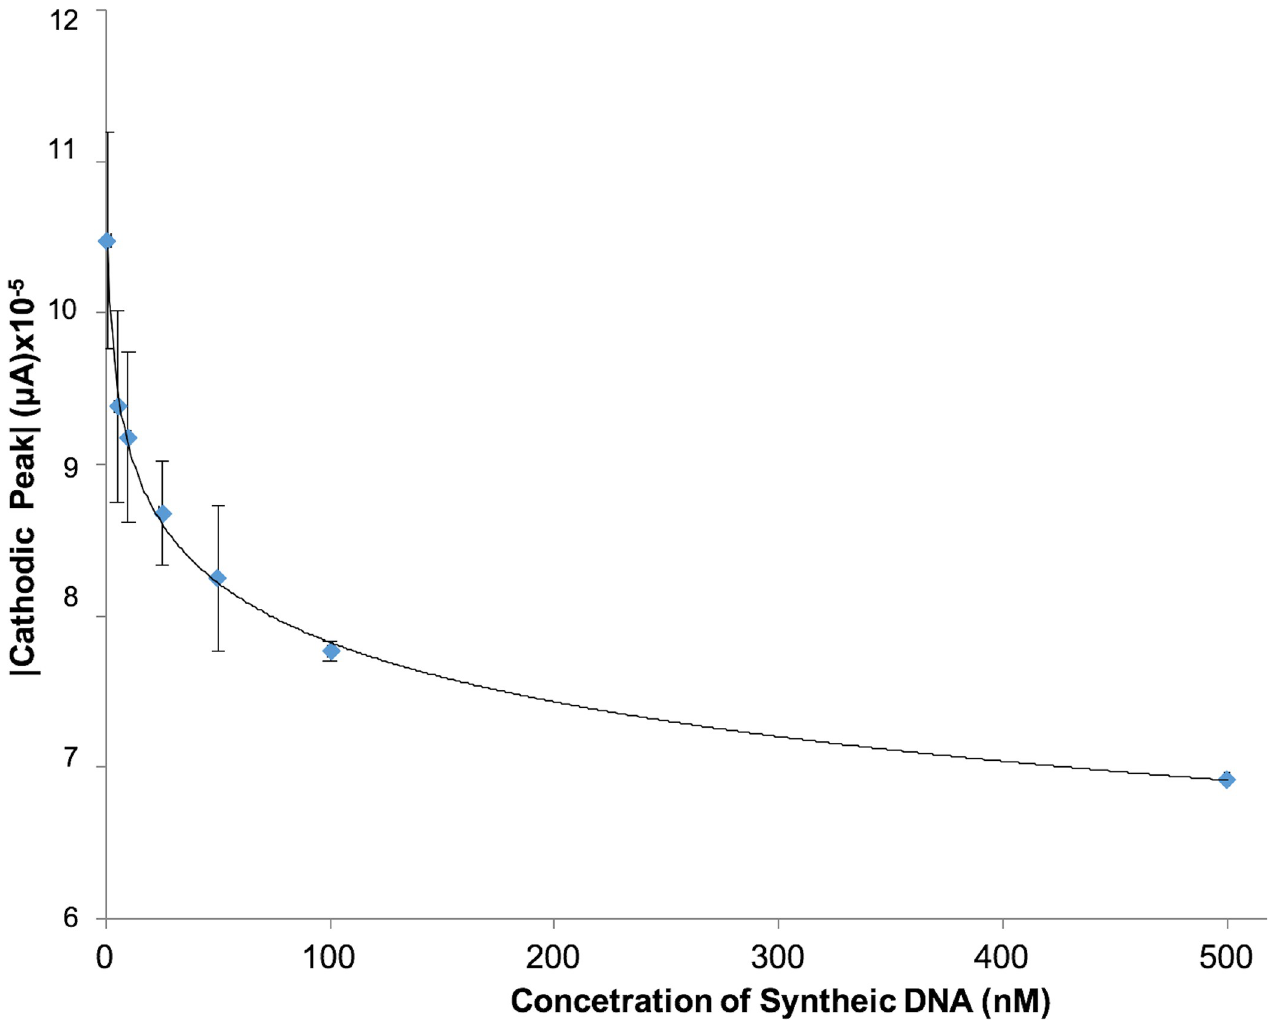
Fig 5. Sensor calibration curve using the absolute value of cathodic current peak versus target DNA concentration in a range 1 nM to 500 nM, showing a logarithmic trend.